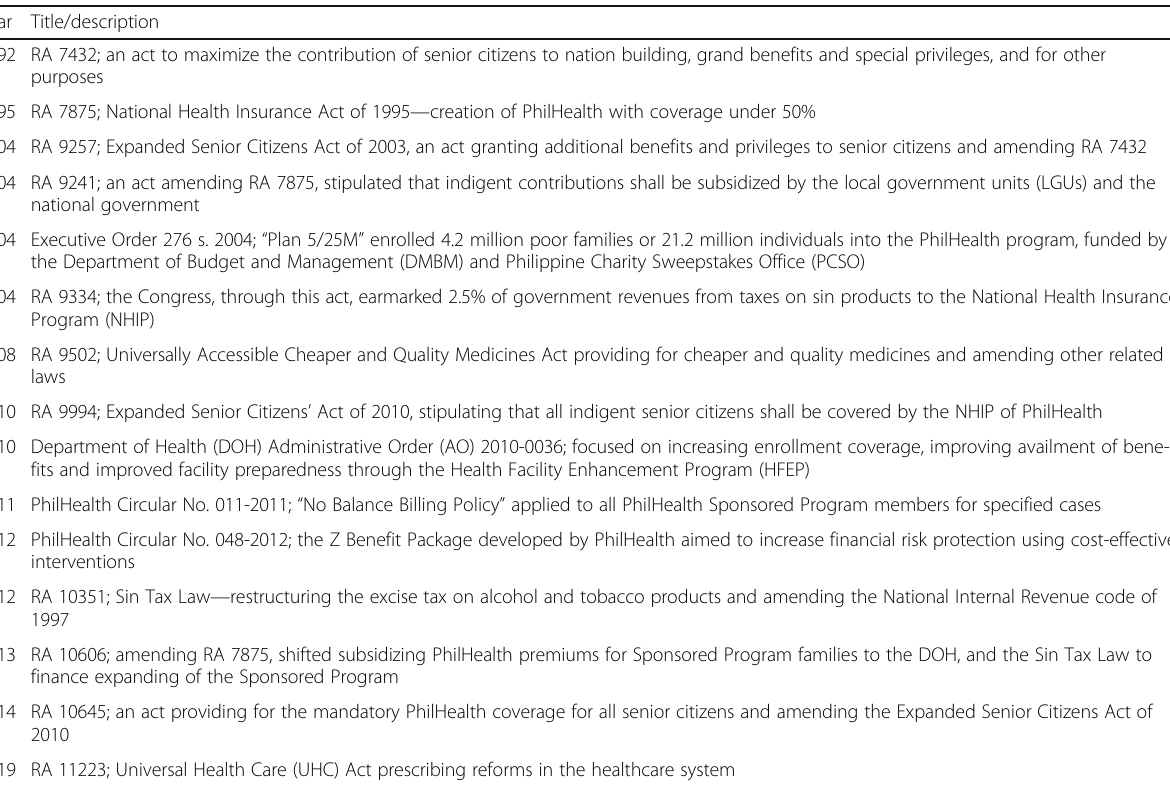
Table 1 Developments in health policies and laws concerning older adults in the